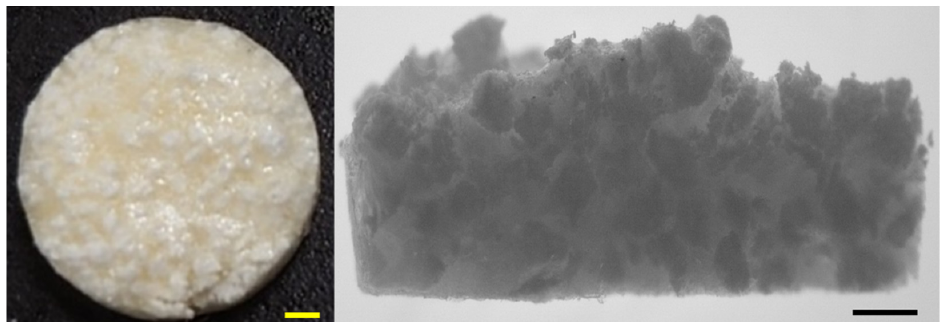
Figure 2. External and cross-sectional view of α -TCP/GS, composite gelatin sponge. Scale bar is 1.0 mm.